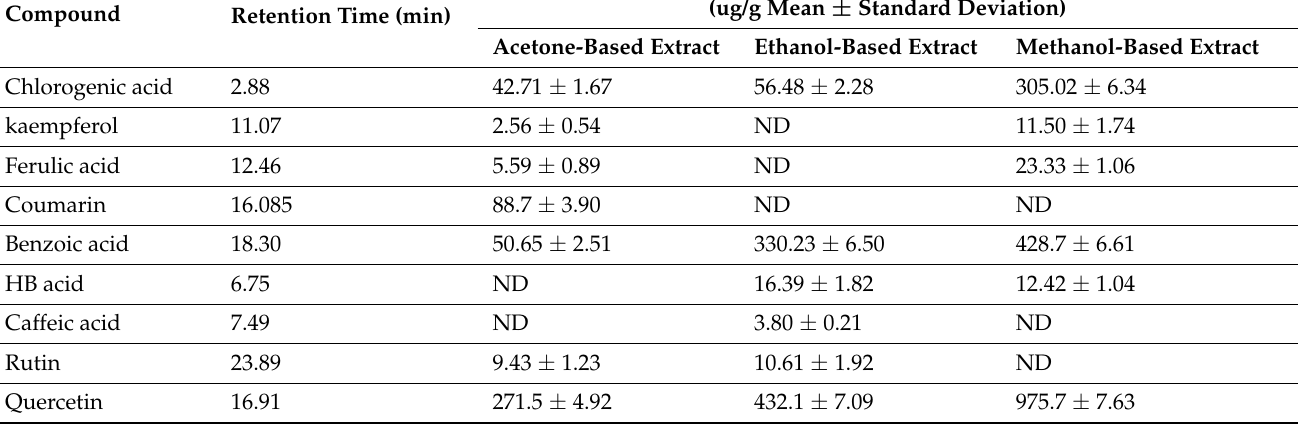
Table 1. Phenolic compounds identified in Coronopus didymus leaf extracts.